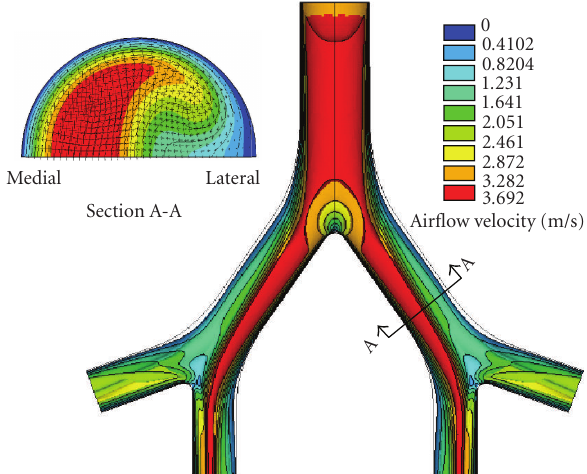
Figure 5: A distribution of the airflow velocity in the airway generations 3 to 5 for the orthotropic flexible model during the peak